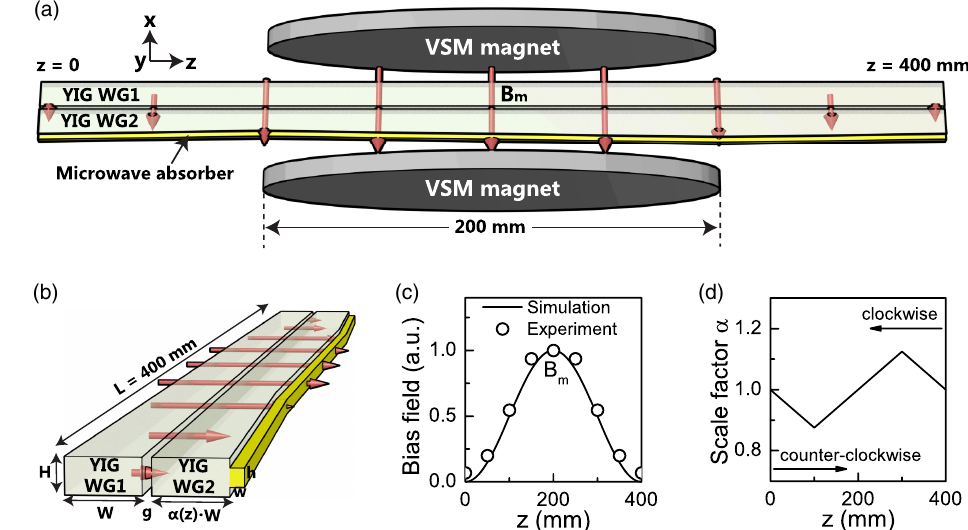
FIG. 2. (a) Schematic diagram of a coupled YIG waveguide system with a length L ¼ 400 mm, where the bias field generated by the two magnets and the width of YIG waveguide-2 vary continuously along the z -axis. (b) Side view of the coupled system. (c) Experimentally measured bias field distributions along the z -axis (circles), fitted using B 0 ð z Þ ¼ B simulations (solid line). (d) Variation in the scale factor α along the z -axis. The minimum α is 0.875 at z ¼ 100 mm and the maximum is 1.125 at z ¼ 300 mm. Injections from z ¼ 0 and z ¼ 400 mm correspond to counterclockwise and clockwise loops,